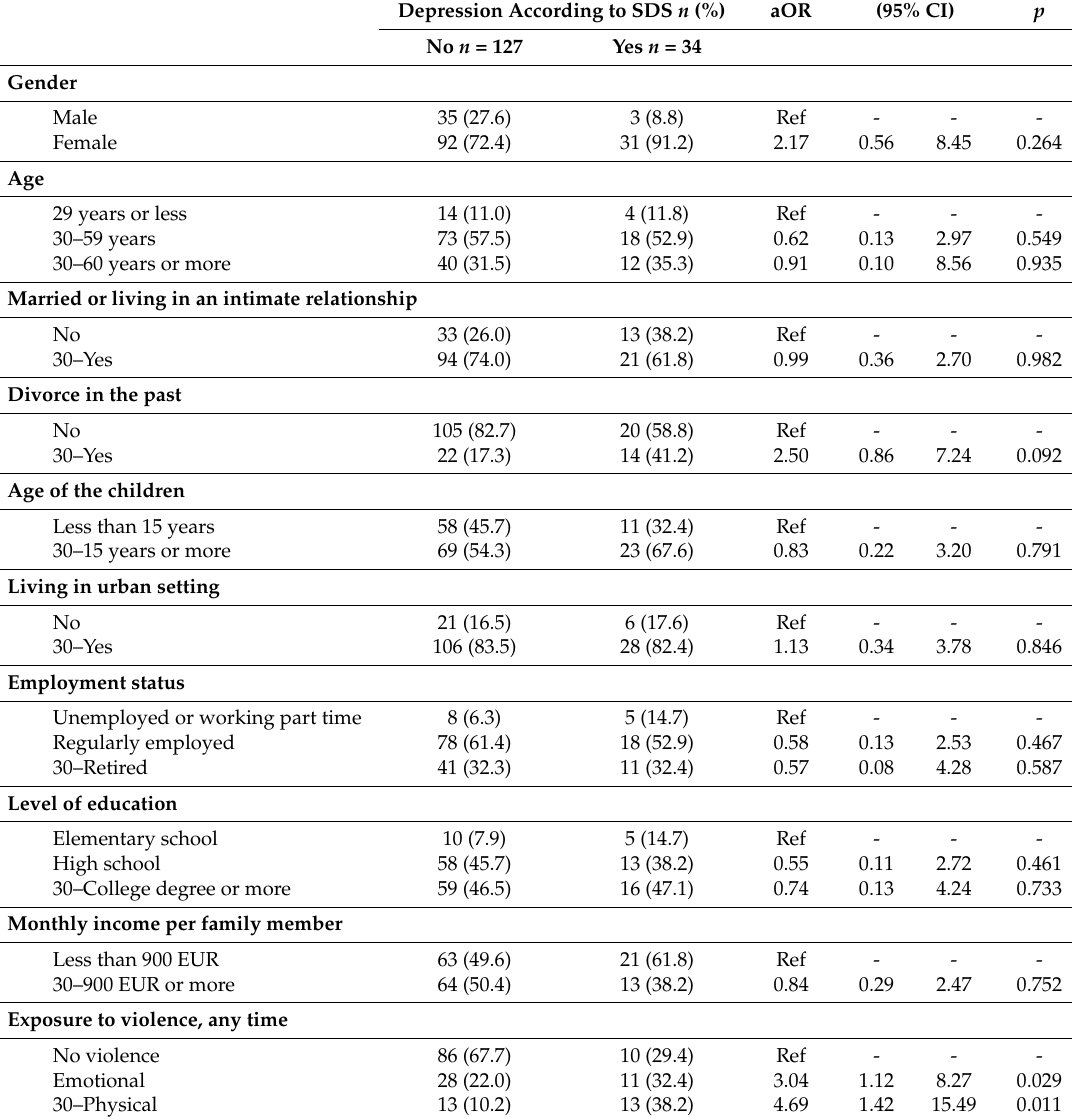
Table 5. Associations between self-rated depression and bio-psycho-social characteristics in